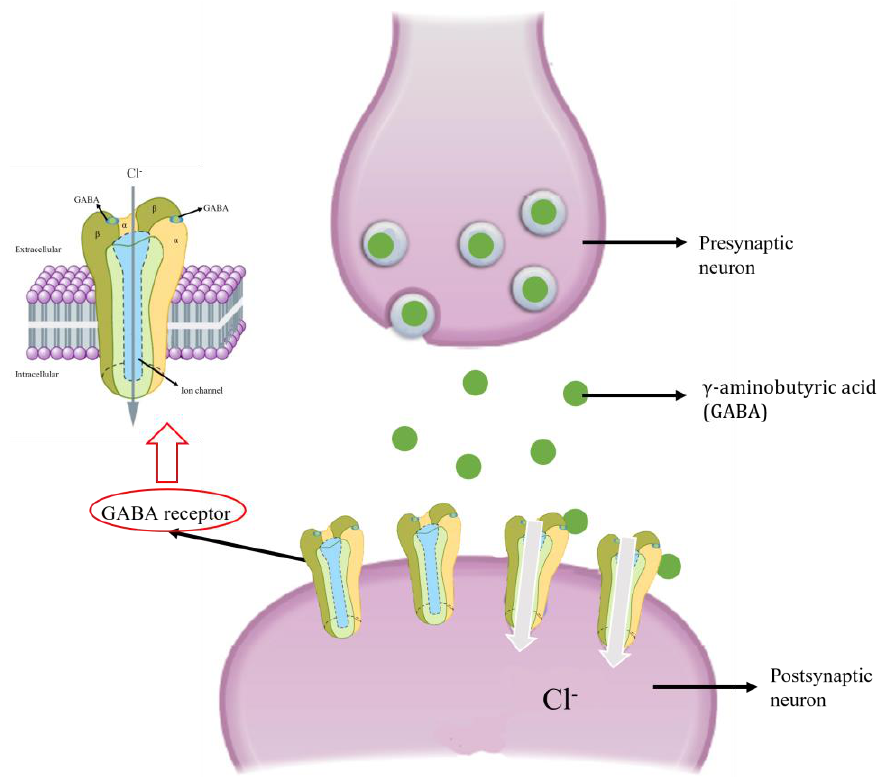
Figure 5. Normal functioning of the GABA/GABARs complex. Modified from Jankowska et al. [113] and Urtasum et al. [120].